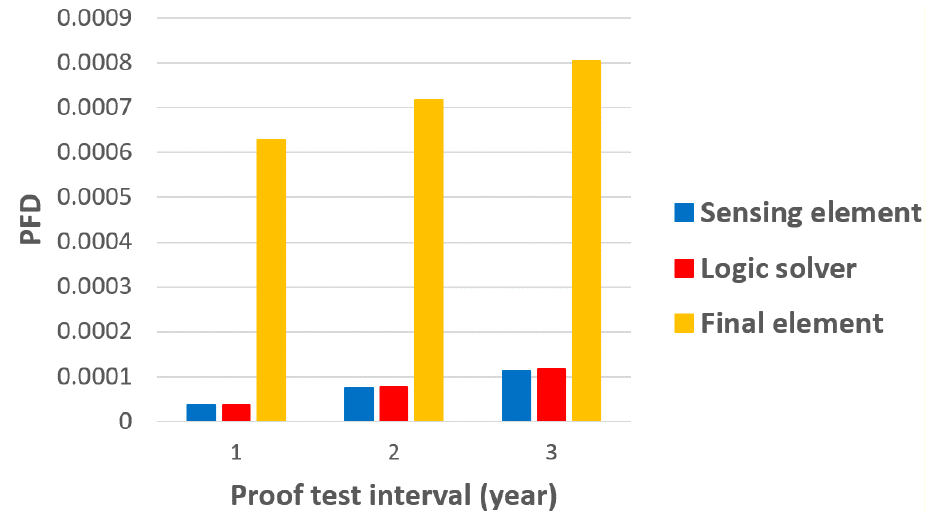
Figure 8. Average PFD of all the subsystems involved in the SIS vs. the proof test interval.